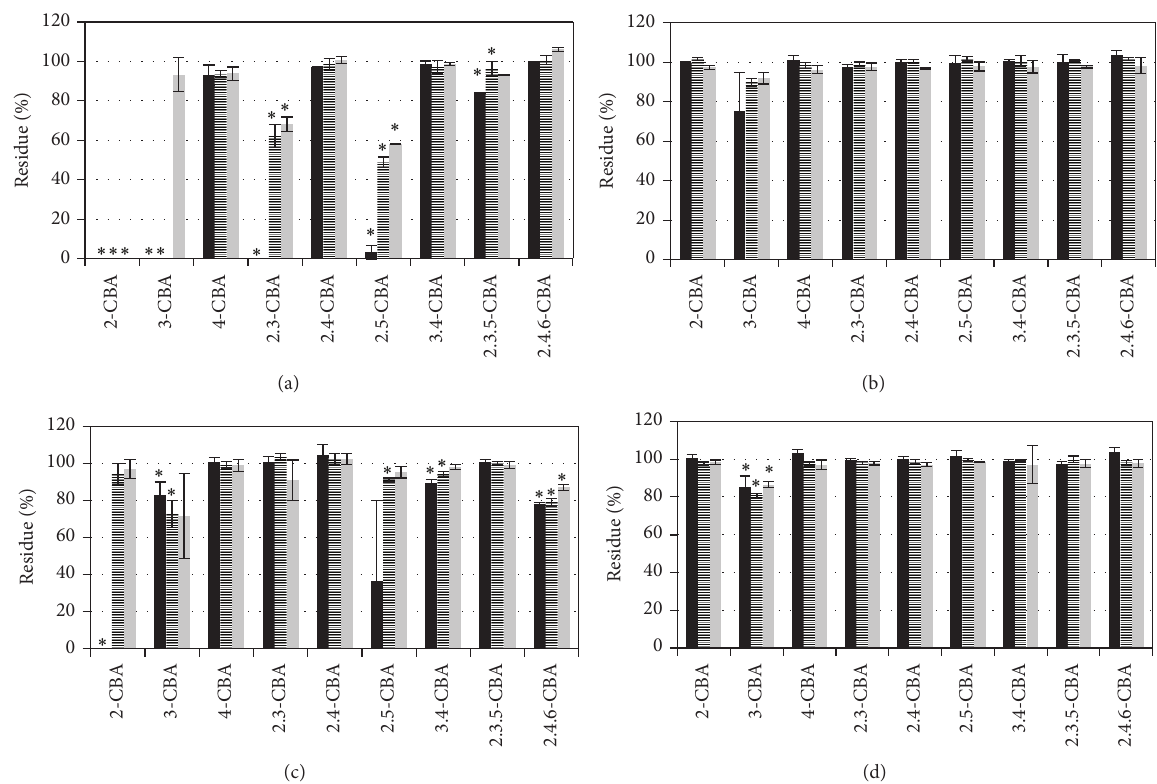
Figure 1: Degradation of single CBA ((a), (c)) and mixture of CBA ((b), (d)) by strains A7 ( Pseudomonas fluorescens ) ((a), (b)) and A8 ( Pseudomonas fluorescens ) ((c), (d)). Black bar in minimal medium, stripped bar in minimal medium with exudates of black nightshade ( Solanum nigrum ), and grey bar in minimal medium with exudates of tobacco ( Nicotiana tabacum ). Stars indicate the statistically significant CBA removal